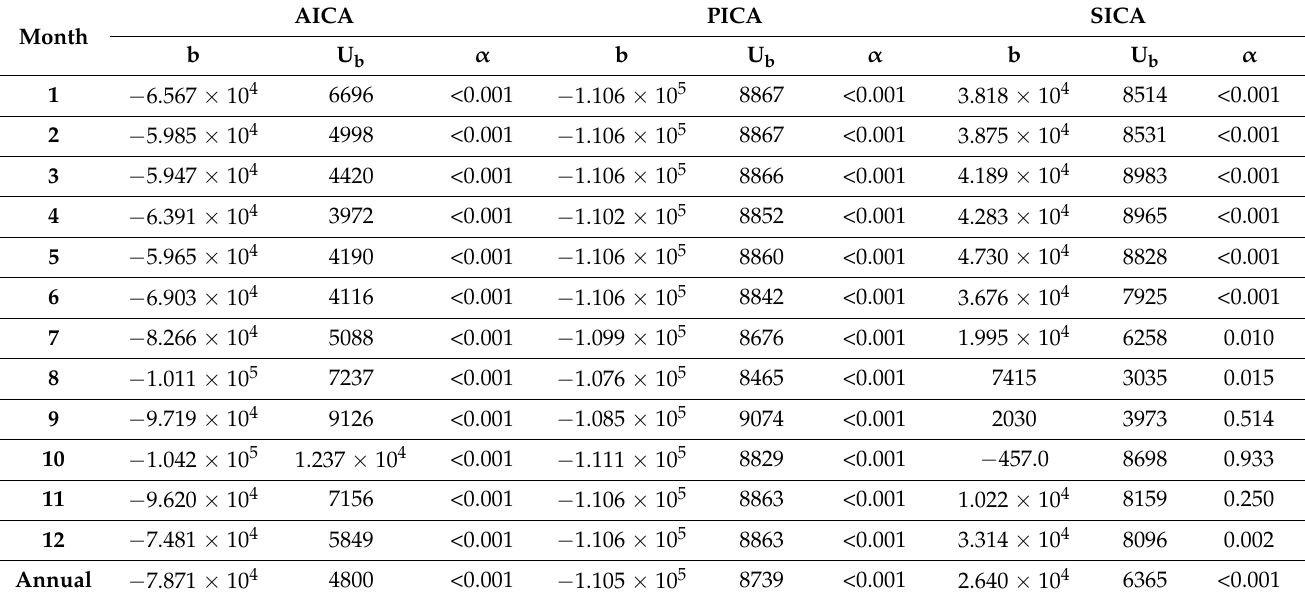
Table 1. Monthly mean SIE trend b (km 2 per year) with its uncertainty U b and confidence level α for AICA, PICA, and SICA over